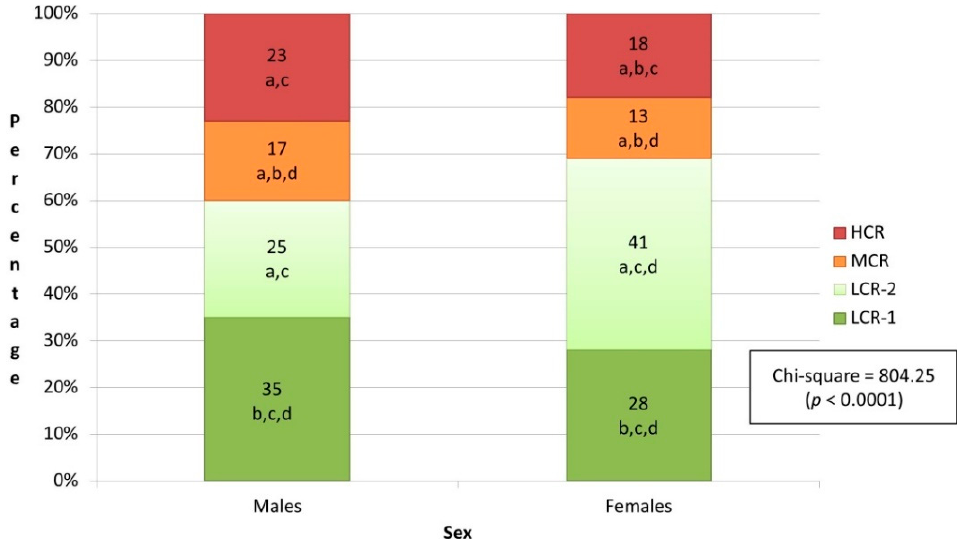
Figure 2. Clusters’ distribution based on sex. Notes: Abbreviations: HCR, high cardiovascular risk; MCR, moderate cardiovascular risk; LCR-1, low cardiovascular risk—group 1; LCR-2, low cardiovascular risk—group 2. Notes: a, statistically significantly different from first cluster ( p < 0.05; 2-tailed); b, statistically significantly different from second cluster ( p < 0.05; 2-tailed); c, statistically significantly different from third cluster ( p < 0.05; 2-tailed); d, statistically significantly different from fourth cluster ( p < 0.05; 2-tailed).